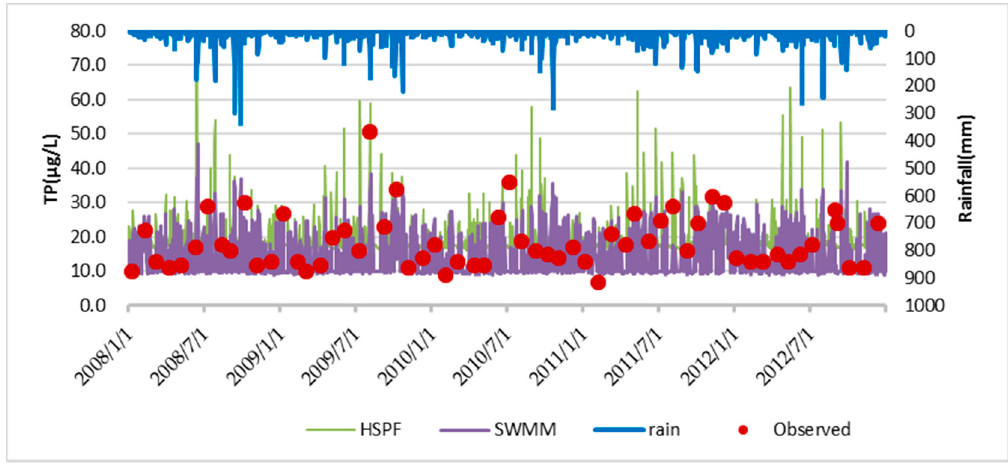
Figure 10. TP concentrations obtained from the HSPF and SWMM simulations and observations.